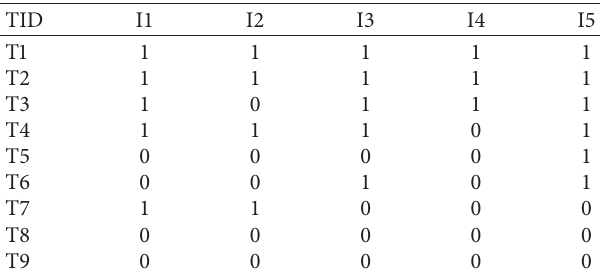
Table 2: Transaction database with